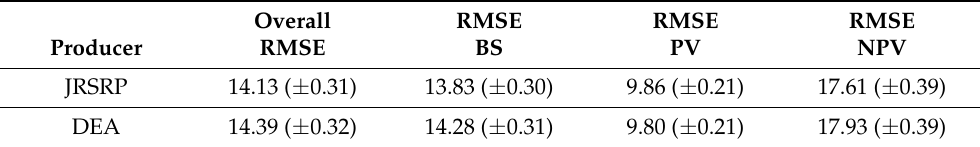
Table 2. Validation results (using SLATS star-transect field dataset) for Joint Remote Sensing Research Program’s (JRSRP) and Digital Earth Australia’s (DEA) vegetation fractional cover algorithms. RMSE: root mean square error (%), PV: photosynthetic vegetation, NPV: non-photosynthetic vegetation, BS: bare soil. 95% confidence intervals are shown between